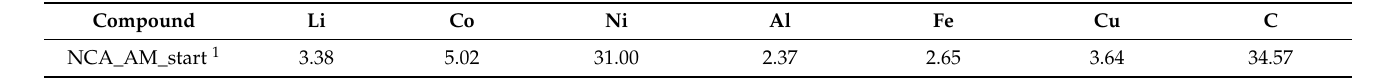
Table 2. ICP-OES analysis of relevant elements in the sample after the hydromechanical preparation in wt.-%.